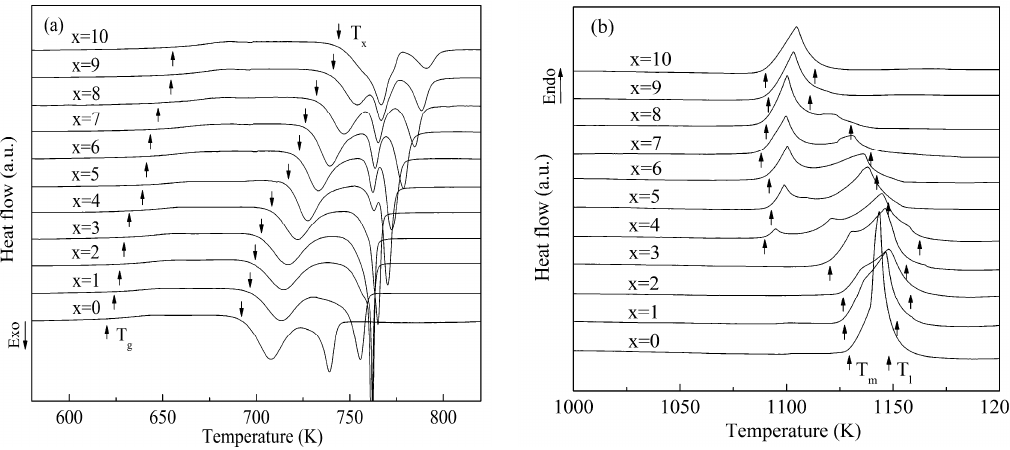
Figure 5. DSC ( a ); and DTA ( b ) curves of the Zr 70 − x Cu 12.5 Ni 10 Al 7.5 Ag x alloys.